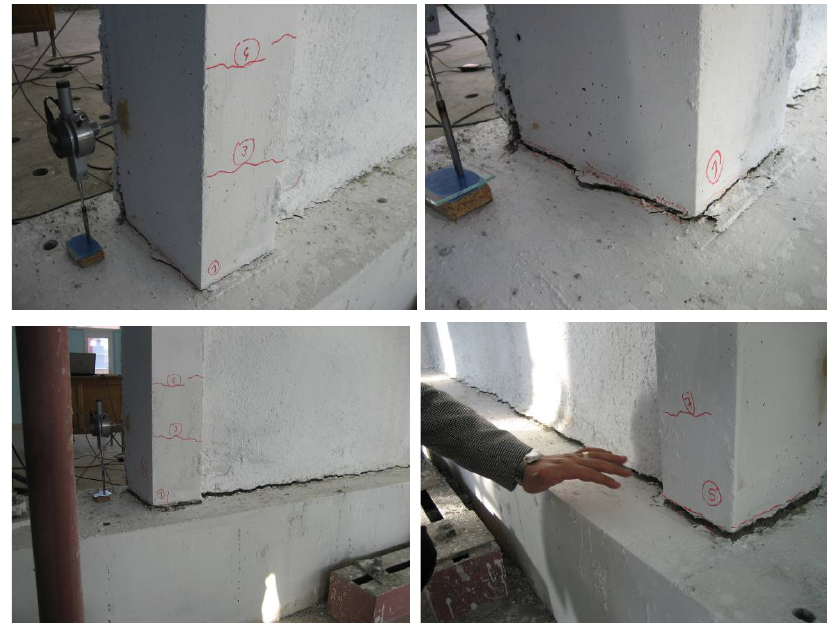
Figure 12 Slip failures at the bottom of the columns Fig. 12. Slip failures at the bottom of the columns. obtained. The reason of the failure attributed to the slippage of the reinforcing bars at the bottom of the columns. The low concrete strength, plain undeformed bars and insufficient lap splice length at the The lateral load-top storey displacement hysteresis curves are presented in Figure 13. The joint created such a failure mode. maximum lateral load obtain during the testing was 63.2 kN, which was %82 higher than bare frame and %50 higher than reference infilled specimen. The wall panels were contributed to the load carried by the system and also increased the stiffness of the frame, but failure of the panel couldn’t be